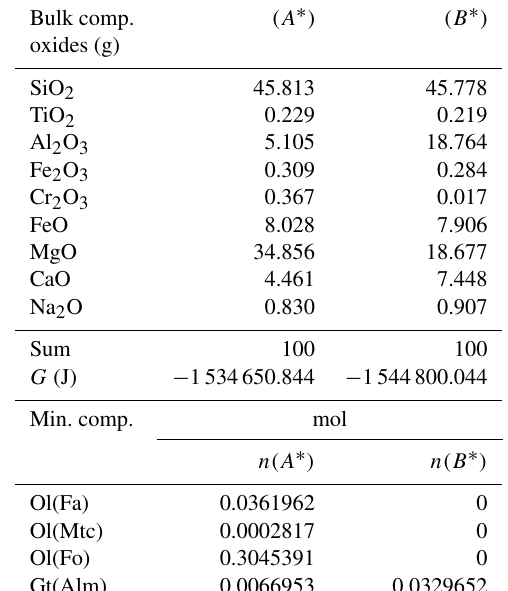
Figure 2a illustrates the variation of G( ∗ ) on both sides at the initial time (black line) and at three different times: 80, 4000 and 20 000 (arbitrary units). Note the increase in the length on the A side and decrease on the B side. Bulk